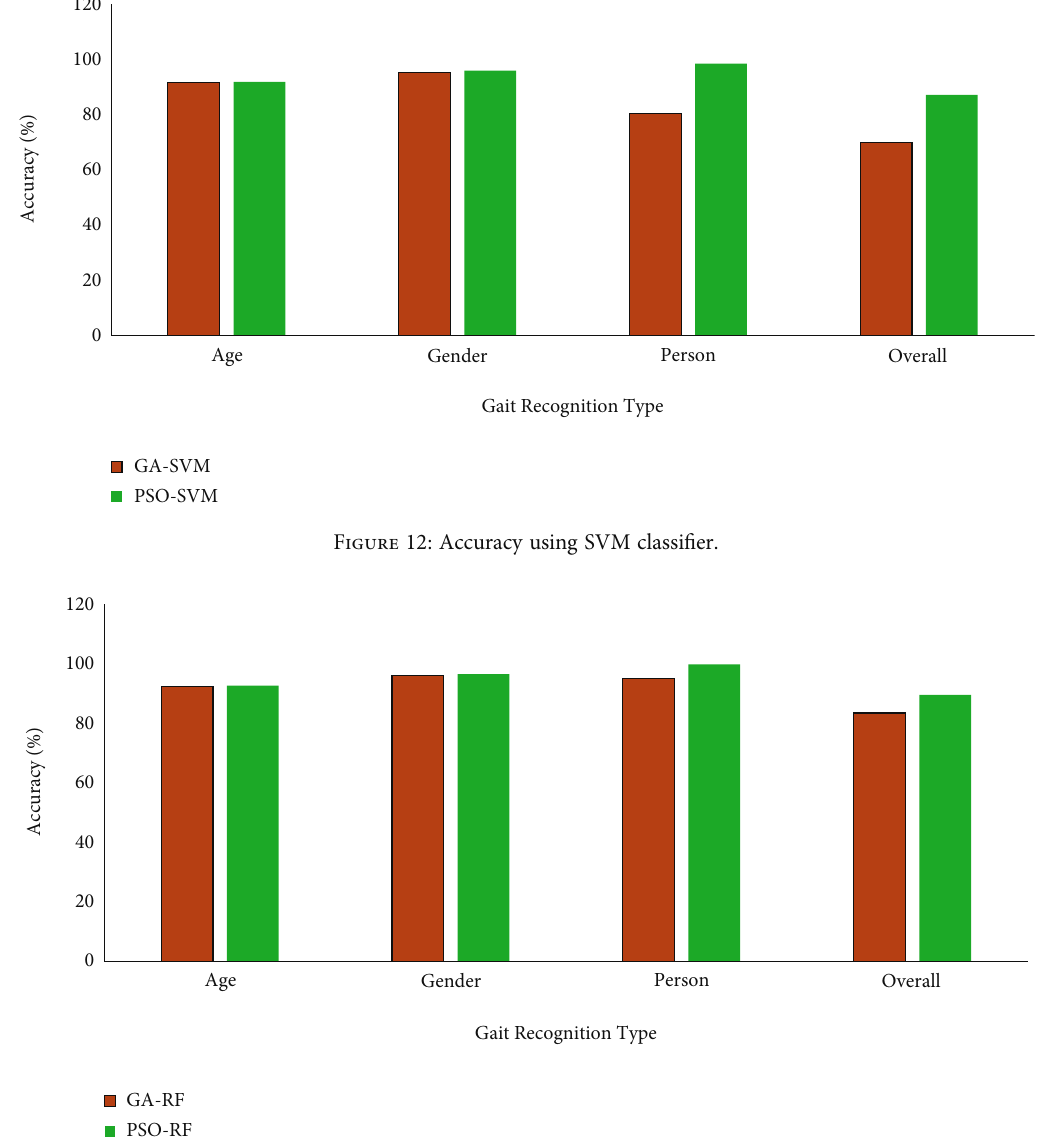
Figure 13: Accuracy using RF classi fi